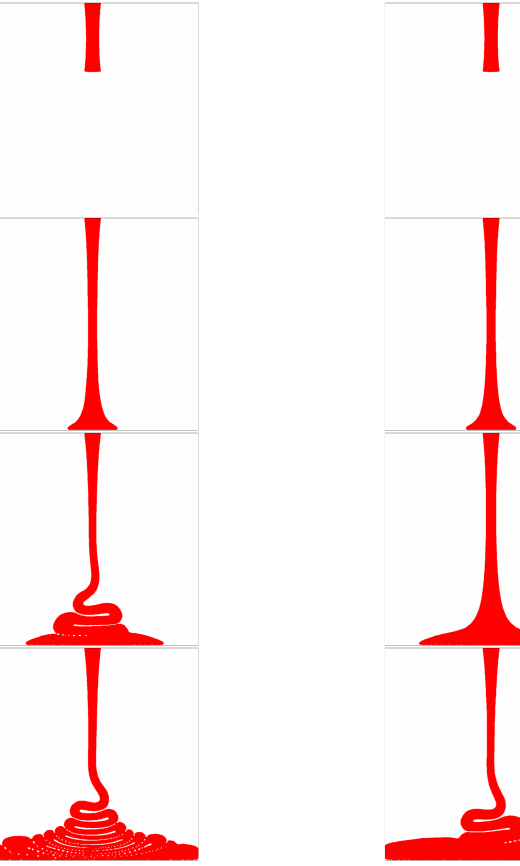
Figure 8. Numerical simulation of a viscous liquid (propergol) jet injected in a square cavity ( 1 m × 1 m ) on a 320 × 320 grid: the interface is plotted at time t = 0.25 s (first row), t = 0.75 s (second row), t = 1.25 s (third row) and t = 2 s (fourth row). First column (FC method), second column (AAL method) and third column (SP